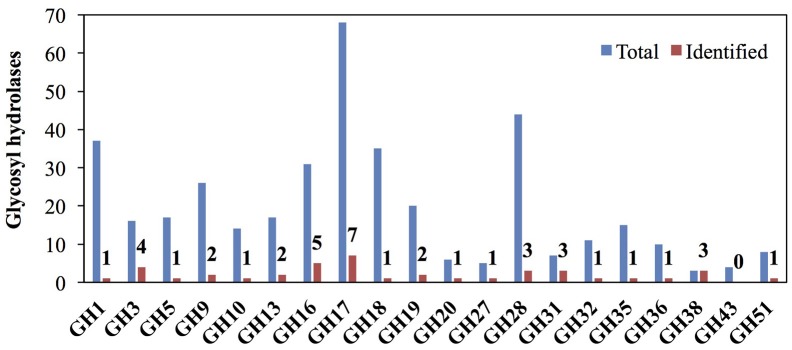
Representation of glycosyl hydrolase (GH) families that may modify or degrade cell walls among rice internode II proteins. Red bars and numbers indicate the GH proteins identified in this study. Blue bars indicate the total number of GH proteins in rice GH database. GH families that modify plant cell wall components, localize to the cell wall, or have much greater numbers in grasses compared to dicots are included.